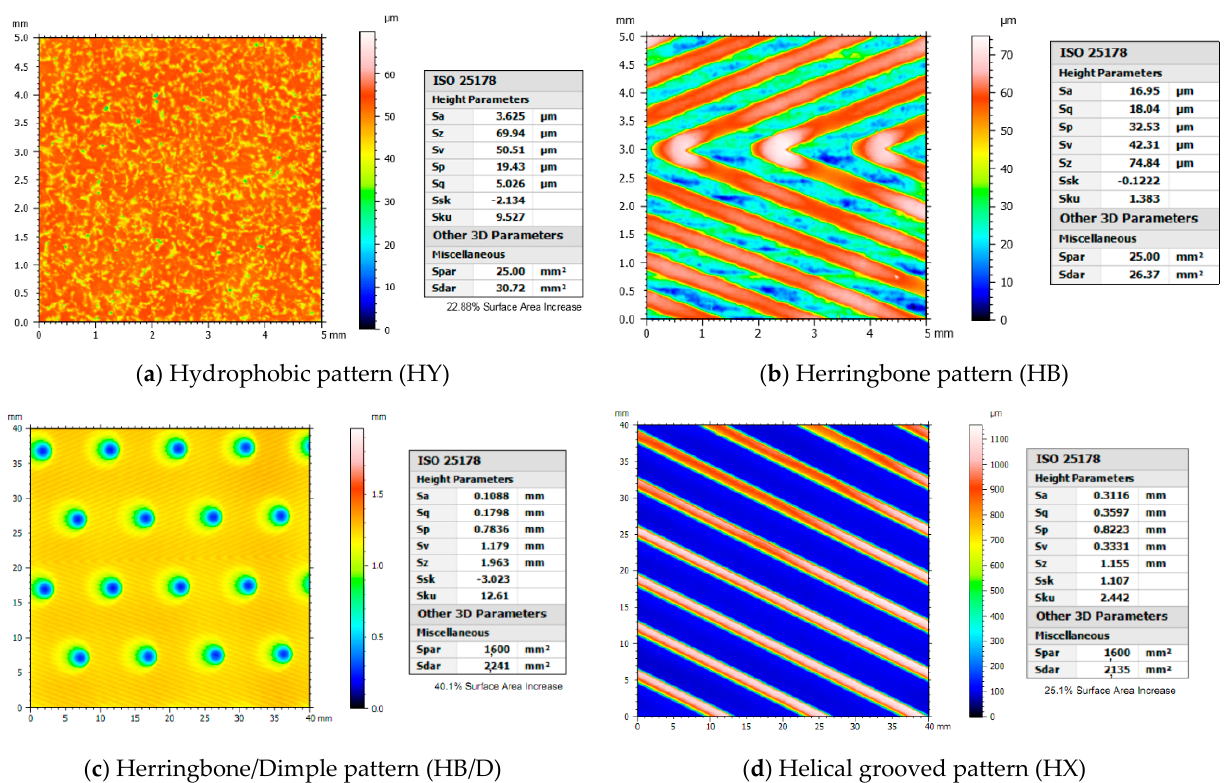
Figure 2. Surface parameters of the enhancement pattern for the ( a ) HY tube, ( b ) HB tube, ( c ) HB/D tube, and ( d ) HX tube. Table 1. Physical measurements of the enhancement patterns used in the various tubes.